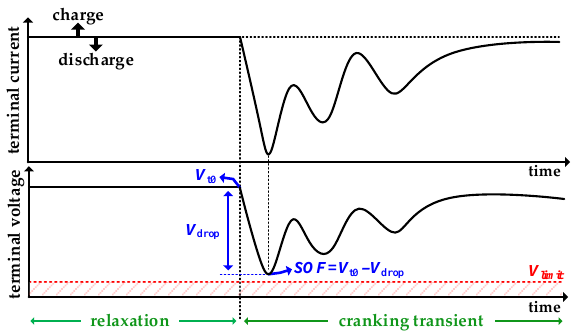
Figure 1. Conceptual figure of terminal current and voltage during cranking transient period.